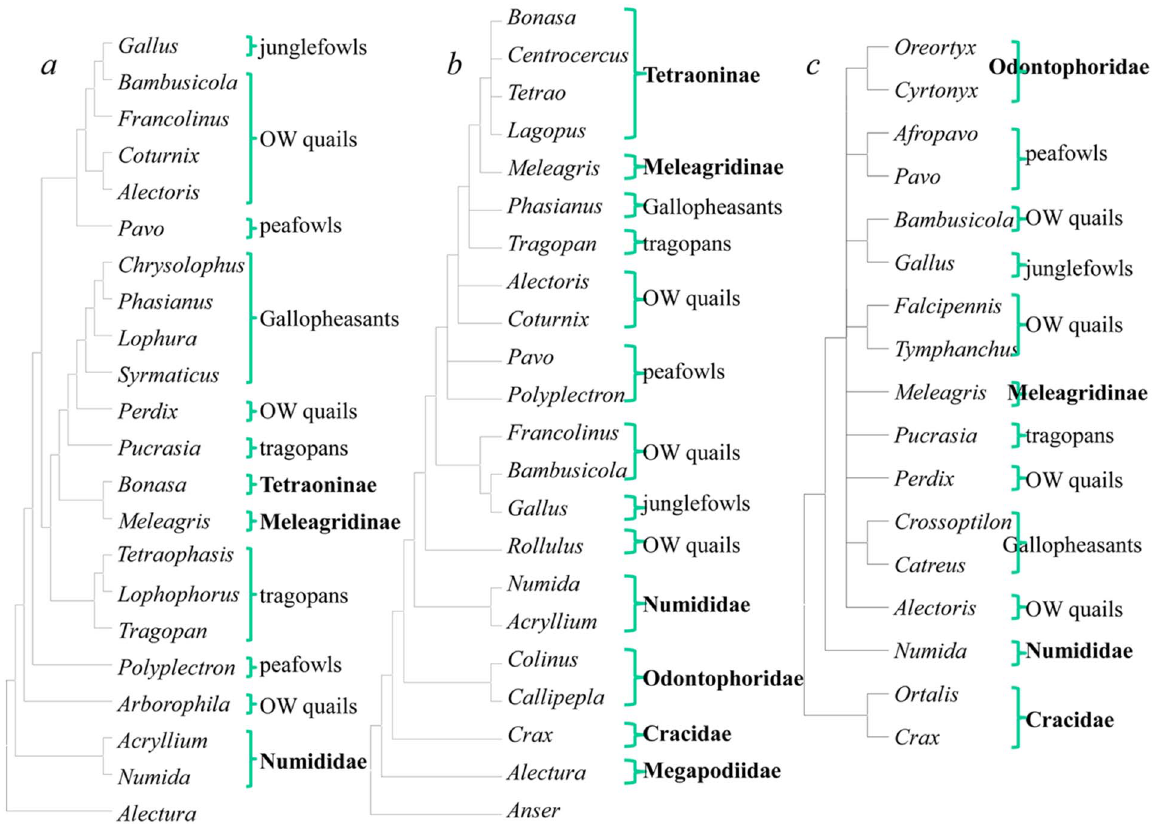
Figure 1. Phylogenetic hypotheses from the mitochondrial (mt) genome and retrotransposable elements for the Phasianidae. (a) Topology based on mt genomes (Shen et al . 2010); (b) topology based on insertion events of CR1 retrotransposable nuclear DNA elements [6,17,20]; (C) topology based on nuclear DNA segments (Crowe et al., 2006).